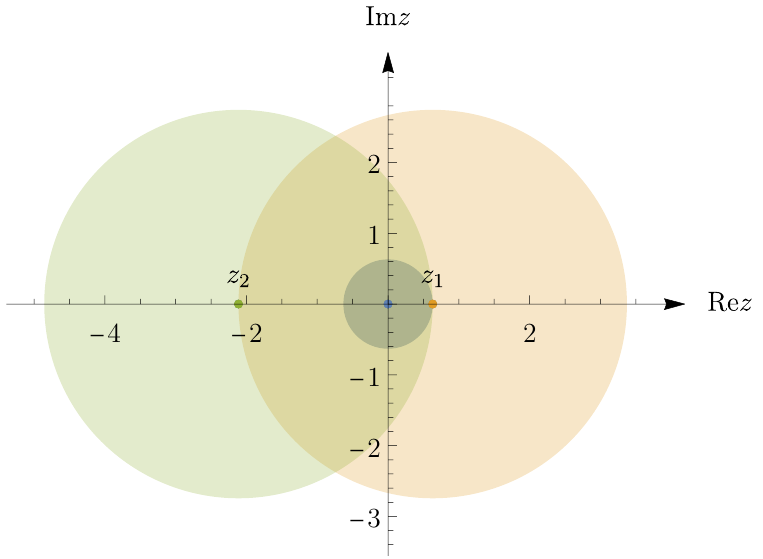
Figure 5. Locations of the points z = 0 , z 1 and z 2 and the disks of convergence of the series expansions of f 0 (eq. (4.3)), f 1 (eq. (4.9)) and f 2 (eq. (4.10)) around z = 0 , z 1 and z 2 ,